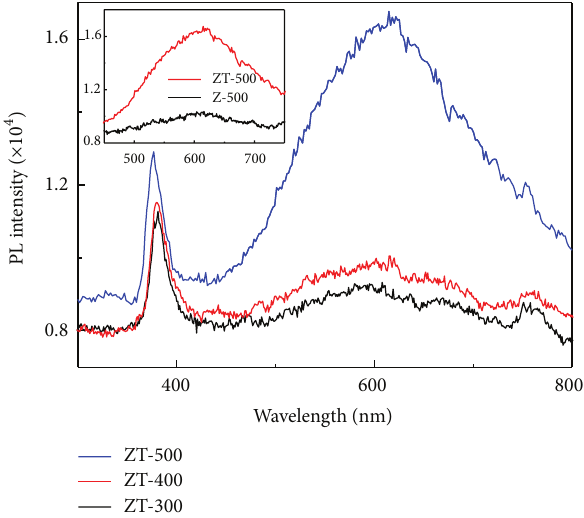
Figure 3: Room temperature PL spectra of ZT-300, ZT-400, and ZT-500. The inset shows visible emission of Z-500, and ZT-500.